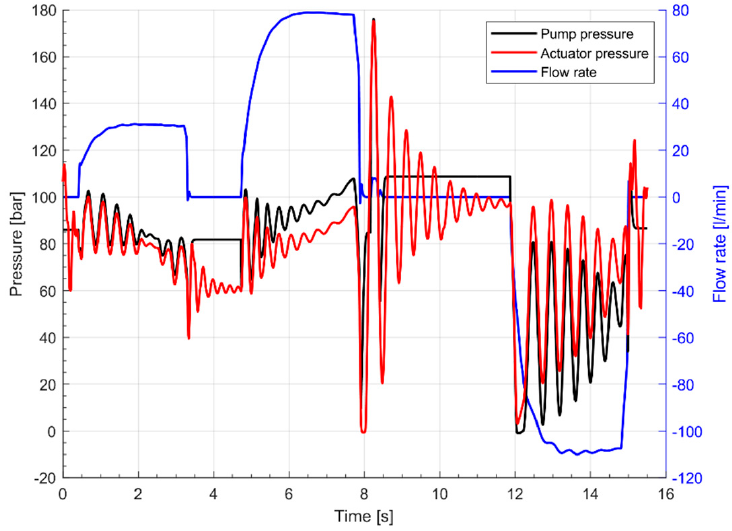
Figure 12. Electric motor power bucket actuator—DDH and DDH with pipes.